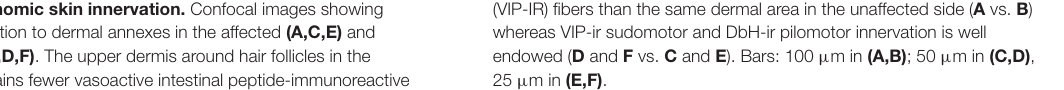
(VIP-IR) fibers than the same dermal area in the unaffected side ( A vs. B ) whereas VIP-ir sudomotor and DbH-ir pilomotor innervation is well endowed ( D and F vs. C and E ). Bars: 100 µ m in (A,B) ; 50 µ m in (C,D) , 25 µ m in (E,F)